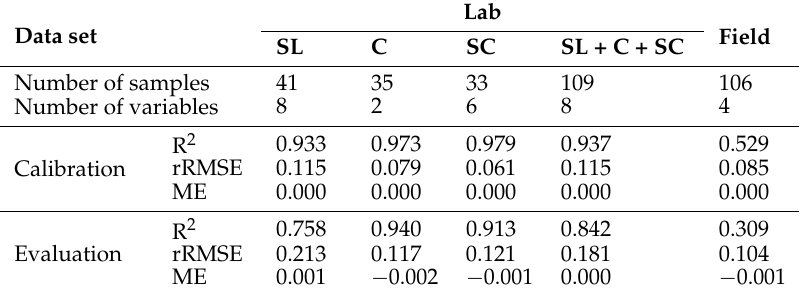
Table 4. Statistical results for the calibration and evaluation of multi-textured soil moisture content models (M_SMC). The number of samples is shown for each calibration dataset. The evaluation dataset has the same number of samples or one less. The number of variables are indicated for each of the stepwise regression equations. Not included is the constant term. Lab Data set Field